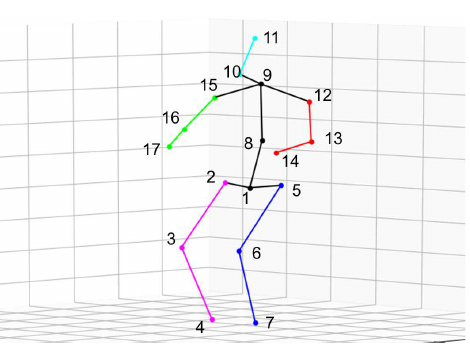
In this study we combine the (cid:28)ndings of the rotation and the translation matrix into a pro- cess, in which the rotation and translation ma- trices are represented in the 3-D space [65] as Eq.